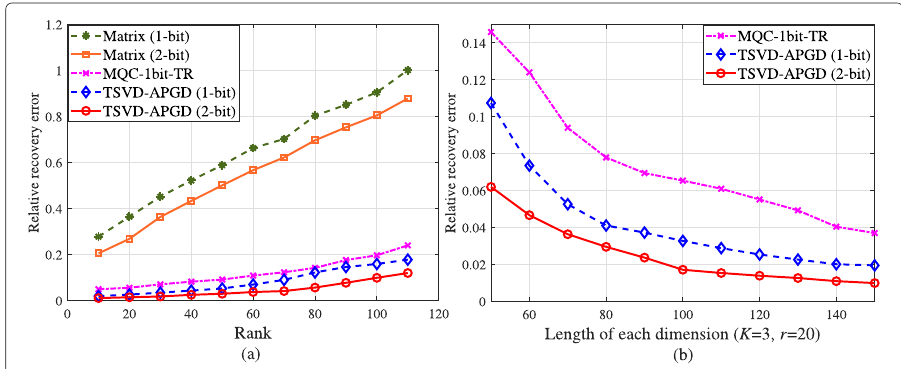
Fig. 3 Recovery performance on SVD-tensor. a Relative recovery error when rank changes. b Relative recovery error when dimension changes